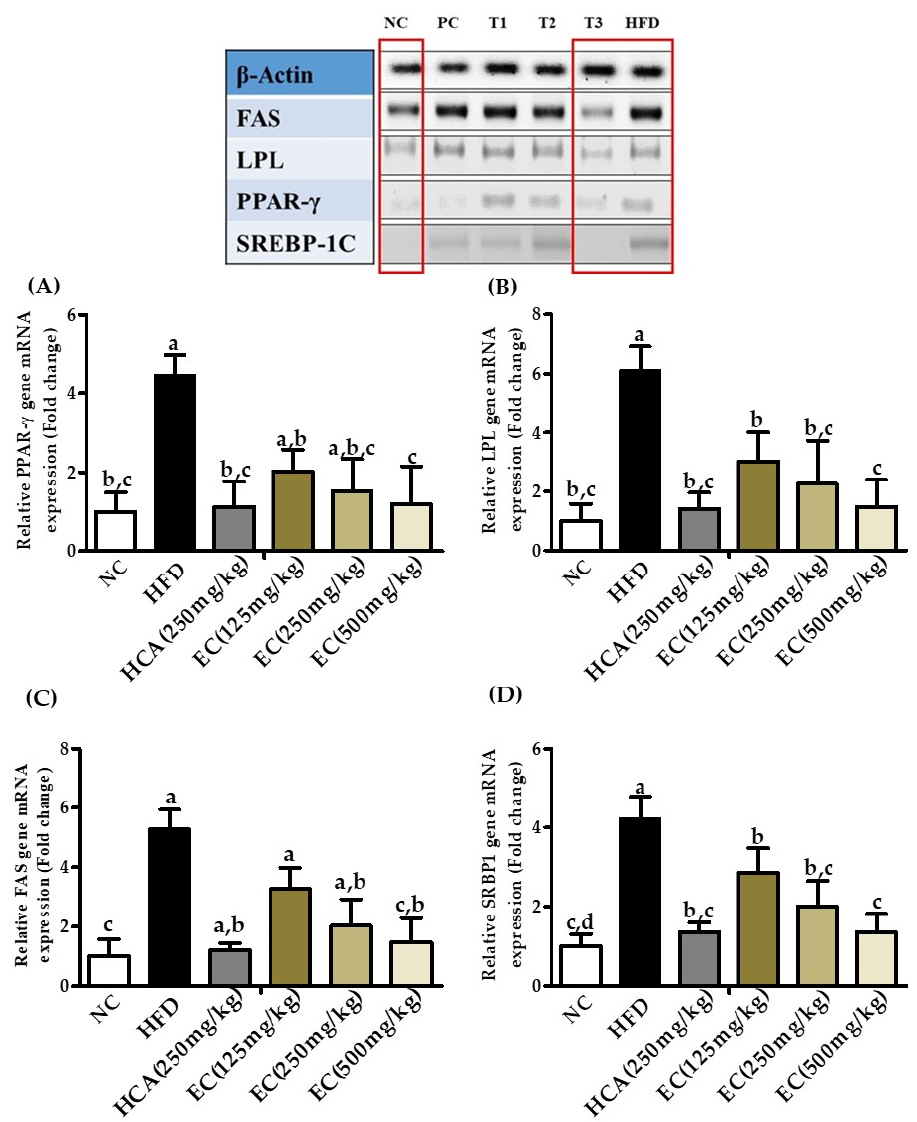
Figure 11. The effects of Ecklonia cava extract on adipogenic and lipogenic gene expression. Total mRNA was extracted from different groups of rats, and qualitative gene expression was assessed by polymerase chain reaction (or endpoint PCR). Results obtained from different groups show that the high-fat diet-induced the up-regulation of ( A ) PPAR- γ (peroxisome proliferator-activated receptors gamma), ( B ) LPL (lipoprotein lipase), ( C ) FAS (fatty acid synthase), and ( D ) SREBP-1C genes that can be reduced by the treatment with E. cava ethanol (70%) extract. In figure, groups are symbolized as: NC (normal control), PC (positive control, i.e., HCA 250 mg/kg b.w), T1, T2, and T3 shows different doses of EC, i.e., 125, 250, and 500 mg/kg b.w, respectively, and HFD (high-fat diet).